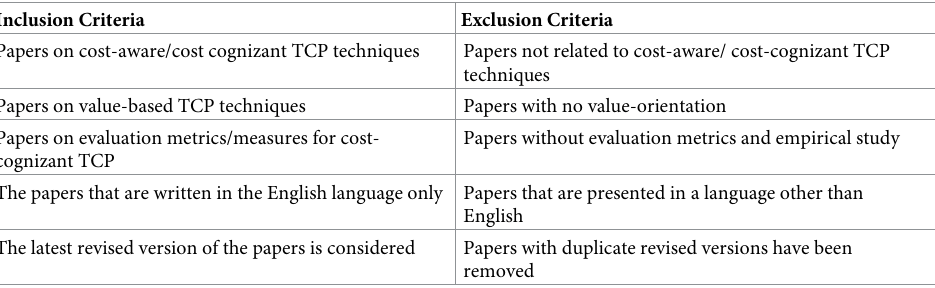
Table 3. Inclusion and exclusion